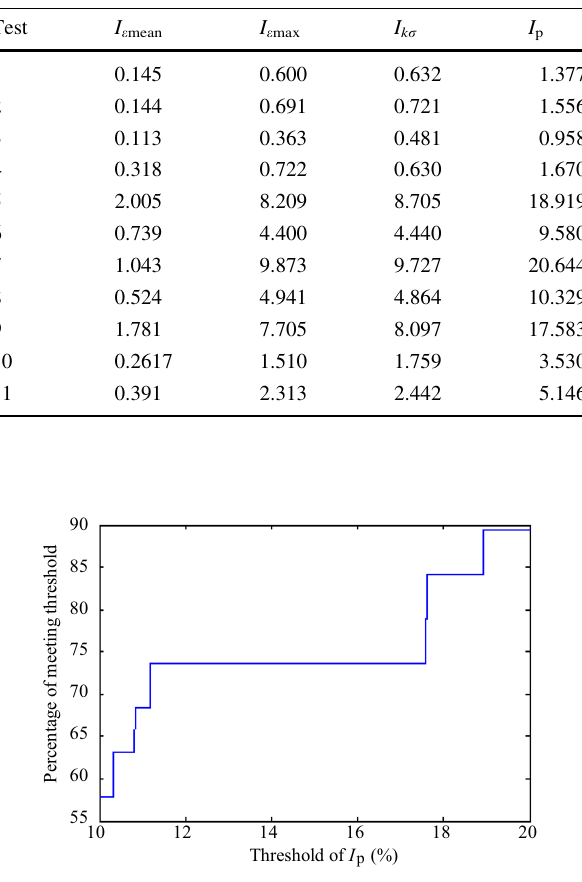
Table 8 Consistency evaluation of the short-circuit currents in Sys- tem C (%)